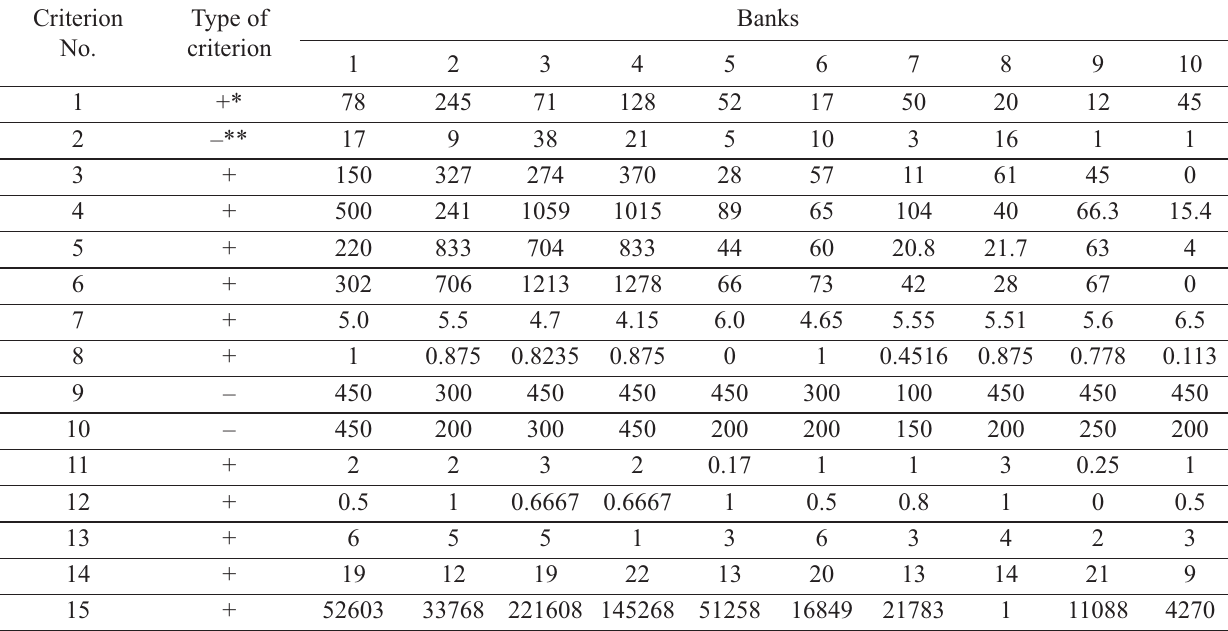
Table 4. Rearranged data on the commercial banks of Lithuania for